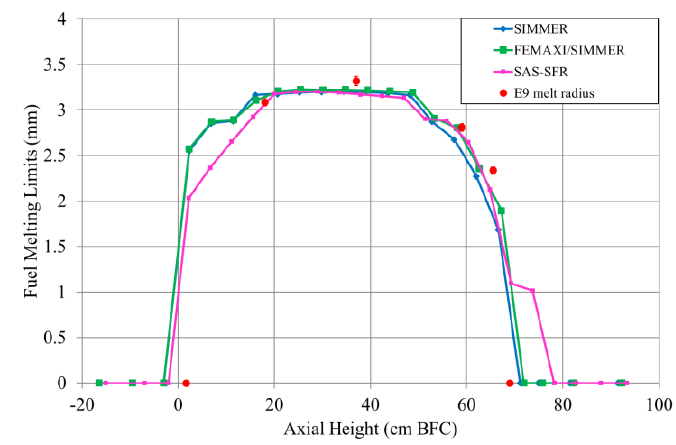
Figure 5. Fuel melting cavity radius at